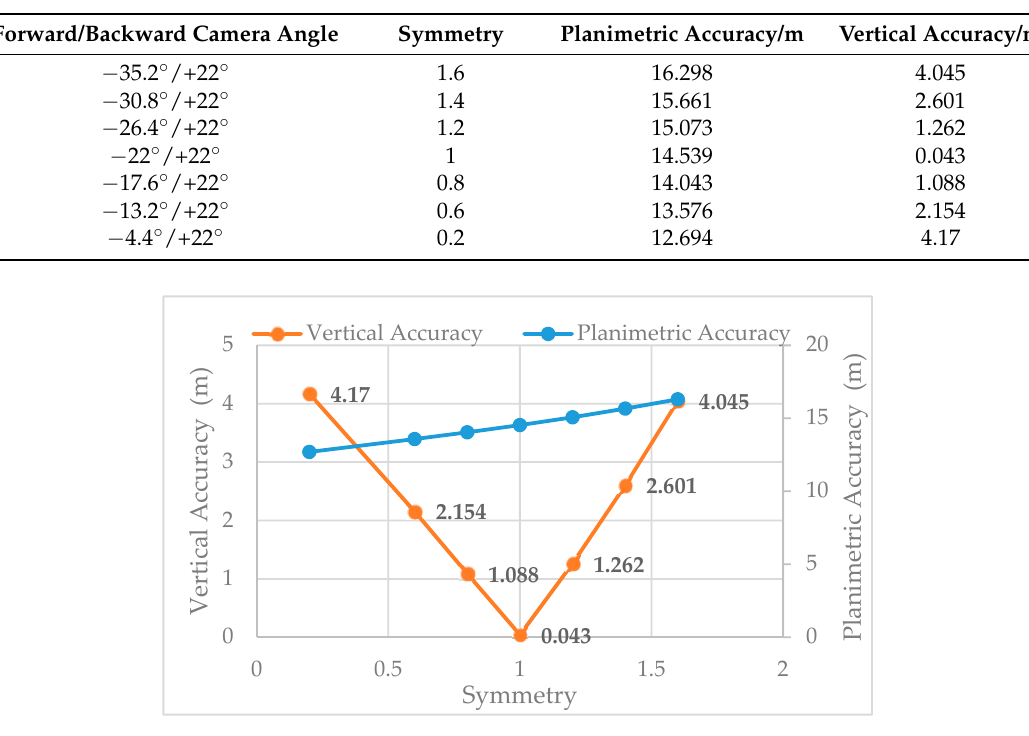
Figure 9. Symmetry and vertical accuracy.